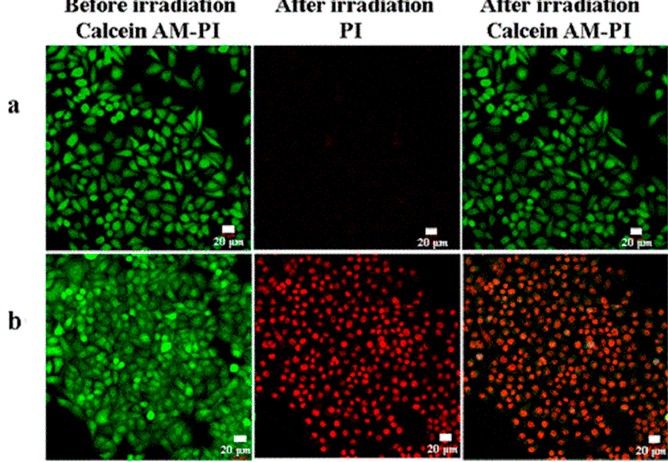
Figure 6. Confocal microscopy images of HeLa cells stained with calcein-AM (green, living cells) and propidium iodide (PI) (red, dead cells) following treatment with ( a ) Phosphate buffer saline (PBS) and ( b ) the SWNH–TSCuPc nanohybrid (TSCuPc, 10 µg·mL − 1 ; SWNHs, 16.5 µg·mL − 1 ). The images were taken prior to and post irradiation with a 650-nm laser. Image adapted with permission from [37].